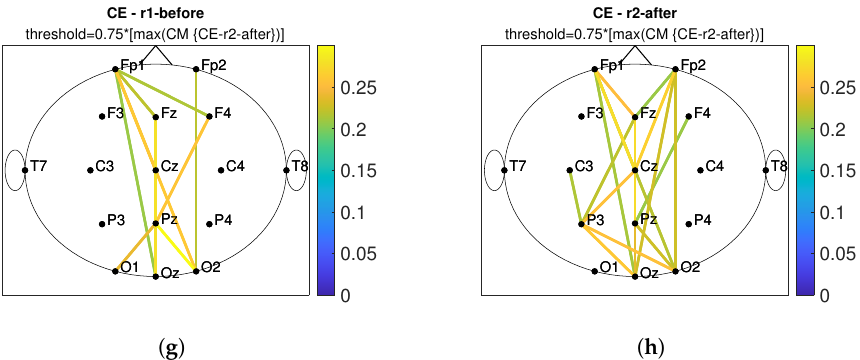
Figure 13. The long-term effect of PBM stimulation in observing the connectivity values of imCPCC comparing the r 1 before and the r 2 after stimulation. The connectivity matrices ( CM ) and the head plot of the connections above threshold between electrode pairs are observed. ( a ) shows the CM under the OE condition for the r 1 before stimulation and ( c ) shows the headplot of the connections, while ( b , d ) show the CM and the headplot of the connections for the r 2 after stimulation. ( e – h ) show the CM or headplot of the CE